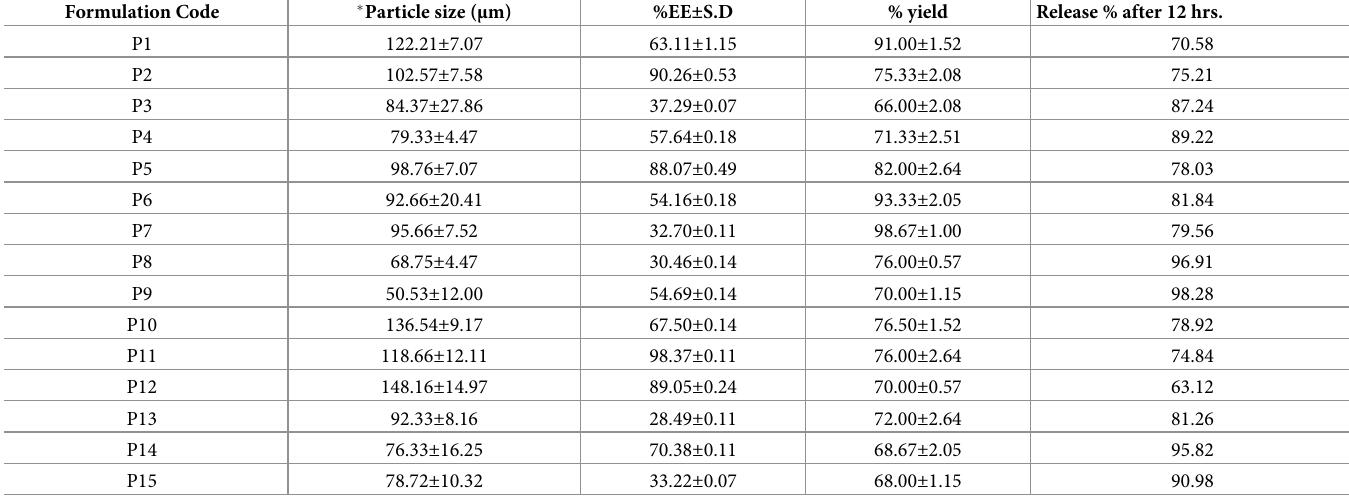
Table 2. Effect of formulation components and process variables on different characteristics of microspheres. Formulation